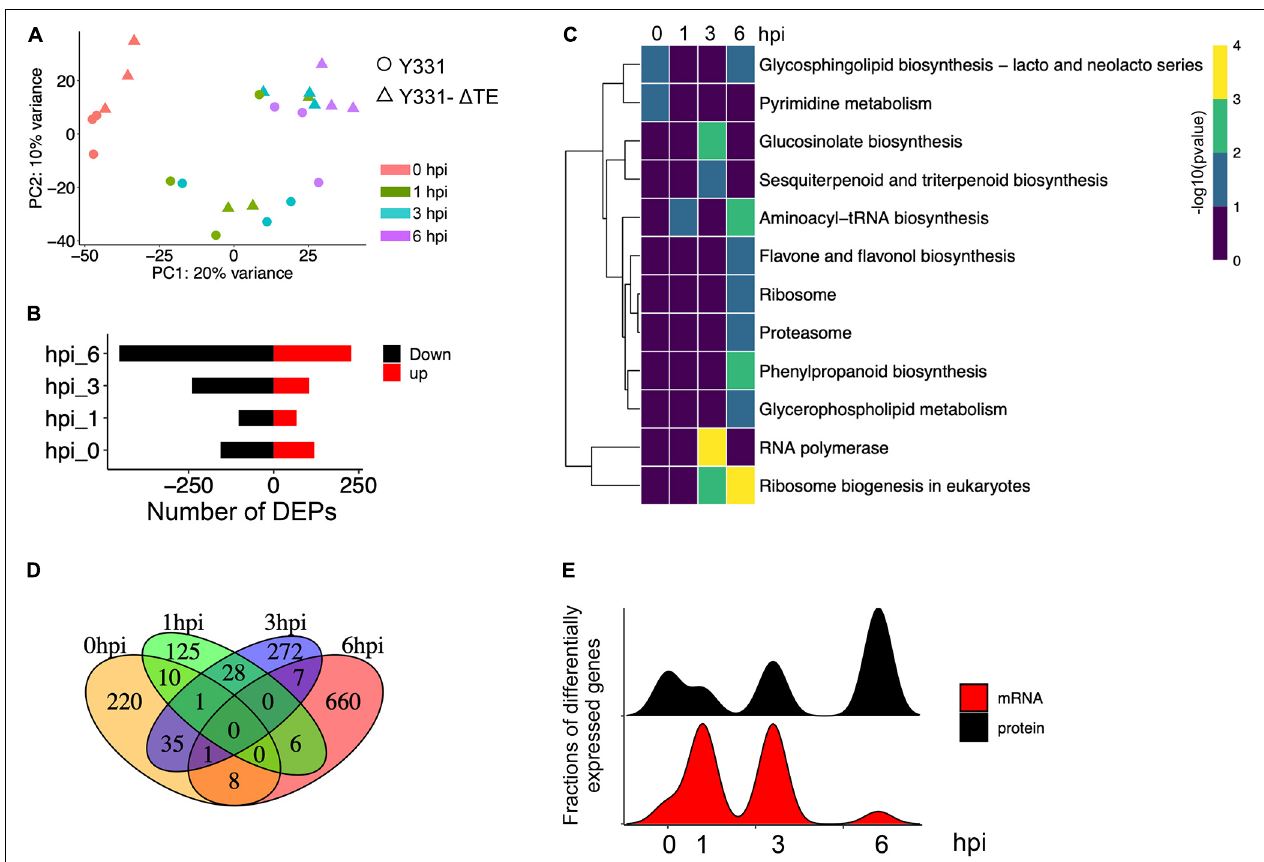
FIGURE 6 | Proteomic analysis revealed a stronger response to infection at the translational level at 6 hpi. (A) Principal component analysis of maize proteomics from Y331- (cid:49) TE and Y331 at different time points. (B) Barplot showing numbers of DEPs as upregulated and downregulated proteins. (C) A dot plot showing the significance of KEGG pathways enriched by DEPs detected in proteomics. (D) A Venn diagram showing numbers of differentially expressed proteins when comparing Y331- (cid:49) TE and Y331 at 0, 1 3, and 6 hpi after inoculation. (E) Density plot showing the relative fraction of DEGs in RNA-seq, and DEPs in proteomics at four time